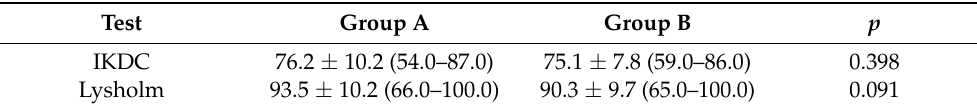
Table 2. Mechanical knee stability in anterior cruciate ligament (ACL) patients. Values are presented as median ± standard deviation. The minimum and maximum values are given in brackets. p values are indicated. IKDC—International Knee Documentation Committee